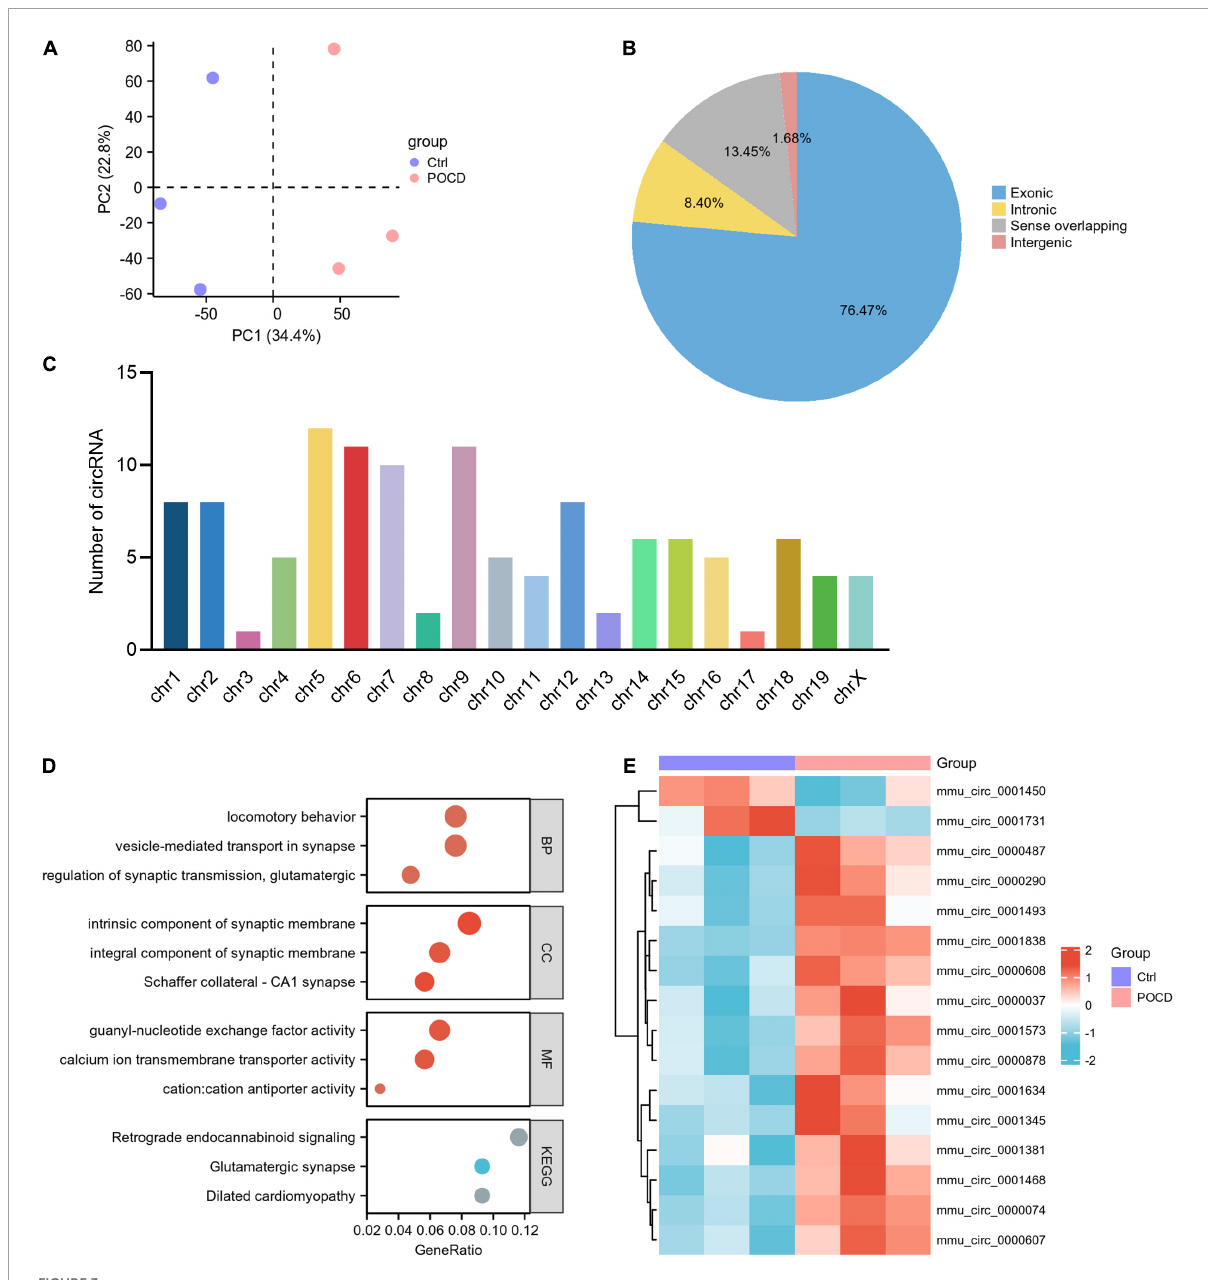
FIGURE3 Characteristics of differentially expressed circRNAs (DEcircRNAs) in postoperative cognitive dysfunction (POCD). (A) Principal component analysis (PCA) of circRNA expression between POCD and control groups. (B) Genomic origin of the DEcircRNAs. (C) Chromosomal distribution of the DEcircRNAs. (D) Functional classifications and pathway enrichment analysis (GO and KEGG) of the host genes of DEcircRNAs. The horizontal axis denotes the proportion of the host genes in each cluster, and the vertical axis denotes biological process (BP), cellular component (CC), molecular function (MF), and KEGG pathway, respectively. (E) Heatmap plots of the 16 circRNAs annotated by